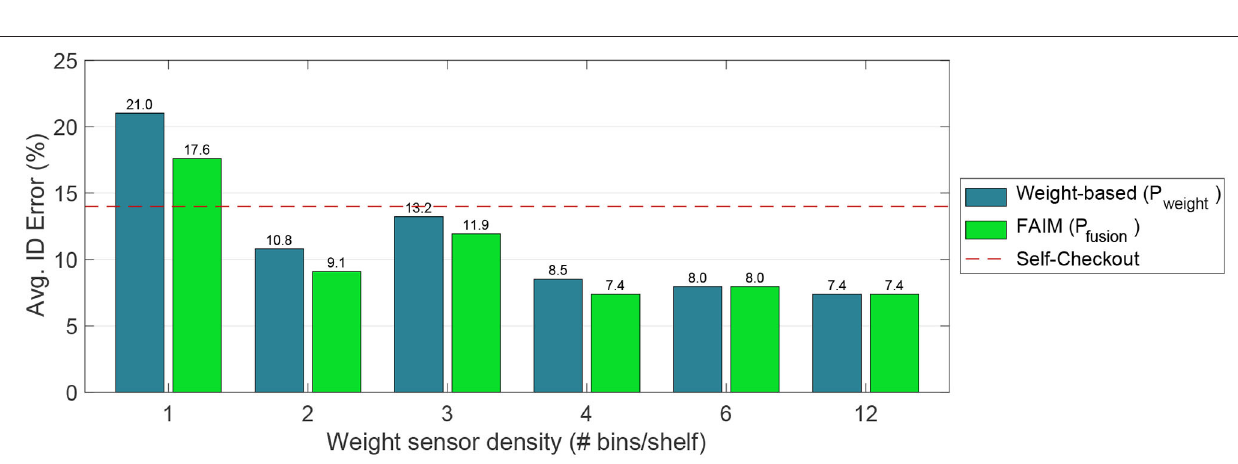
FIGURE 12 | Item identification error for different bin widths. Note the reduction in error when vision assists weight (FAIM, beige, is consistently better than no fusion, green). Starting at 2 bins/shelf the Avg. ID Error is already smaller than Self-Checkout ( Beck,